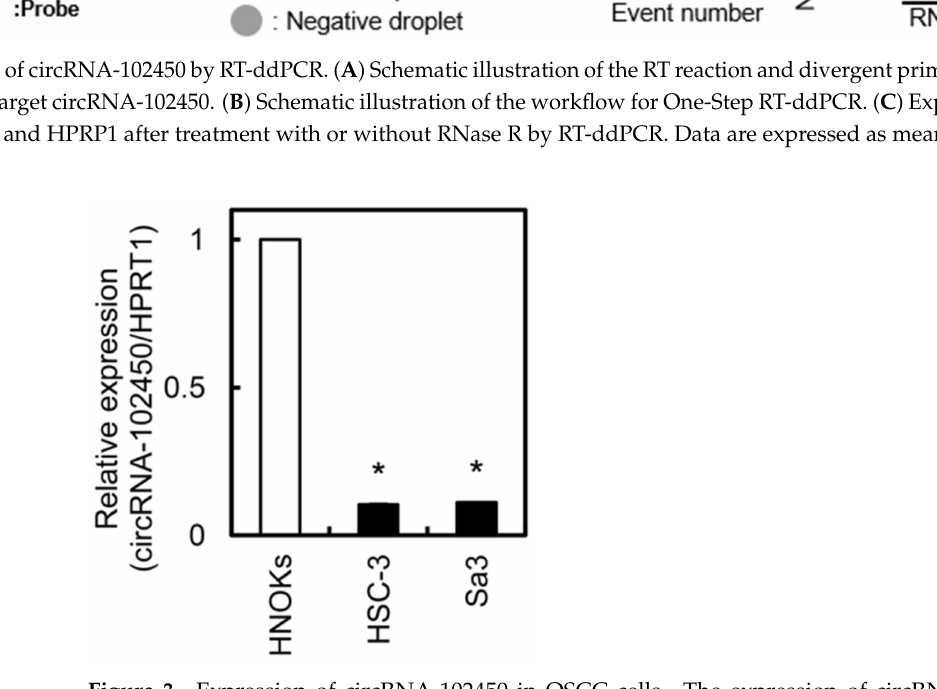
Figure 3. Expression of circRNA-102450 in OSCC cells. The expression of circRNA-102450 in OSCC cell lines (HSC-3 and Sa3) and HNOKs was evaluated by RT-ddPCR. Data are expressed as means ± SD (* p <